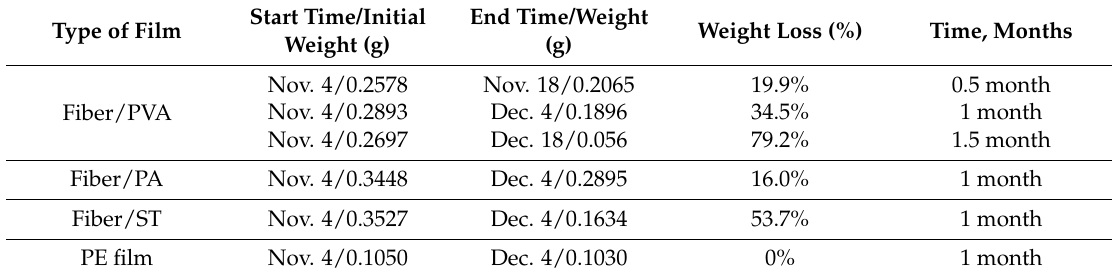
Table 2. The weight loss of fiber/polymer films after different degradation time by soil burial test.